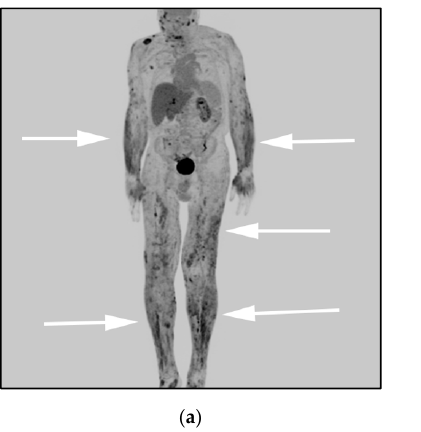
Figure 2. ( a ) F-18 FDG PET/CT maximal intensity projection (MIP) image in a different patient with diagnosis of primary cutaneous ALCL, ALK-negative variant, shows hypermetabolic diffuse dermal and subcutaneous nodularity extending from the top of head throughout bilateral upper arms, upper thighs and lower feet (white arrows). ( b ) F-18 FDG PET/CT axial images show hypermetabolic subcutaneous nodules/masses in the head, and anterior face (white arrows).